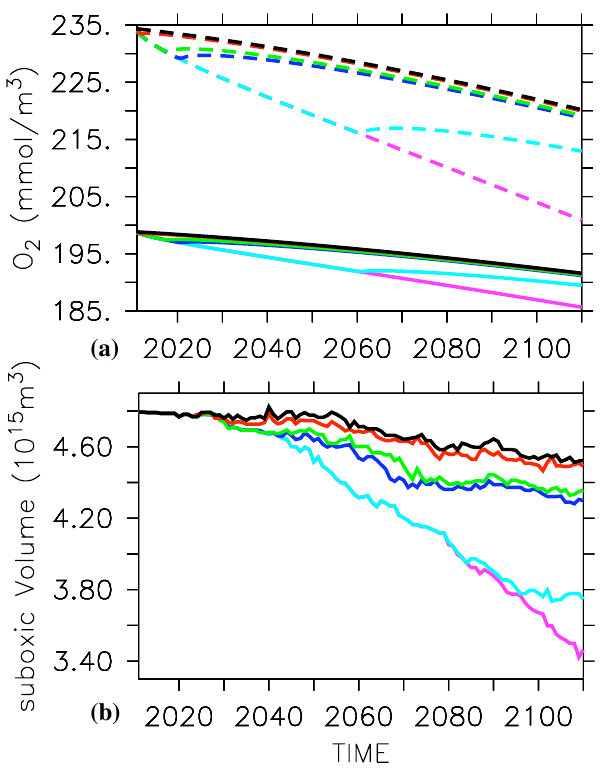
Fig. 4. (a) Simulated oxygen concentrations averaged over the fer- tilized area (south of 30 ◦ S – dashed lines – and globally – solid lines. (b) Simulated global-ocean suboxic volume, defined by oxy- gen concentrations lower than 5mmolm − 3 . Colored lines refer to model fields after 1 year of OIF (red), 7 years (green), 10 years (blue), 50 years (cyan), and 100 years (magenta) of continuous OIF south of 30 ◦